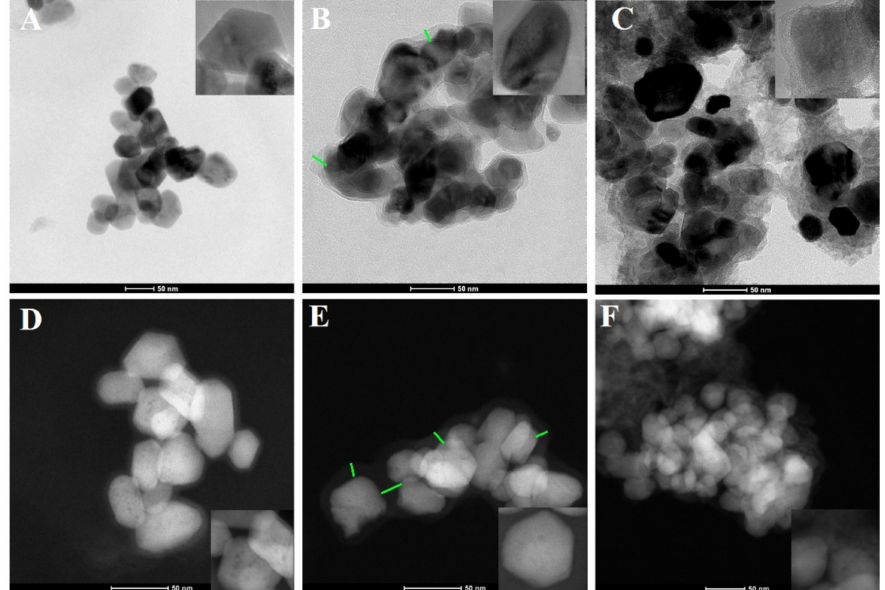
Figure 3. The morphological structure when using STEM as the material after surface function- alization and ELG loading. ( A ) The images were taken by TEM for pristine ZnO NPs, ( B ) ZnO NPs–NH 2 –COOH–TRP, and ( C ) ZnO NPs–NH 2 –COOH–TRP–ELG. ( D ) The images were taken by STEM for ZnO NPs, ( E ) ZnO NPs–NH 2 –COOH–TRP, and ( F ) ZnO NPs–NH 2 –COOH–TRP–ELG. The green lines show the coating shell layer, as indicated by TRP-functionalized